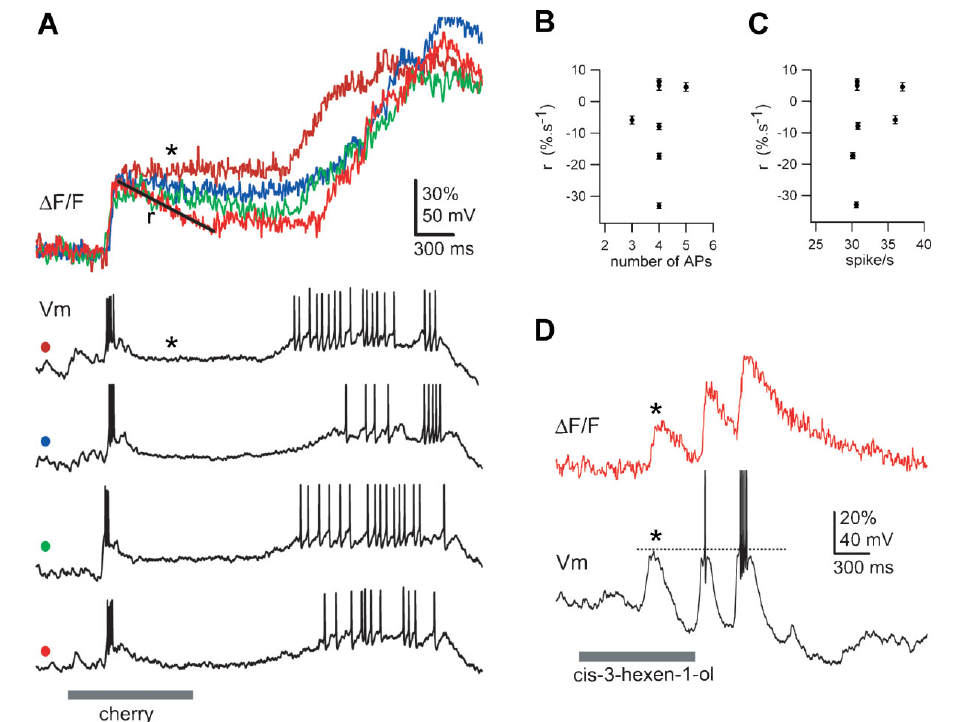
Figure 4. Calcium signals are not always correlated with spiking . ( A ) Seven glomeruli were successively imaged in this PN, using constant odor delivery conditions. Single trials of V m and F responses evoked by 1-second pulse of cherry odor are shown for four glomerular tufts (four colors). PN was held very slightly hyperpolarized. Note consistency of early F and V responses across glomeruli, to be contrasted with lack of correlation between F (linearly quantified as a rate r ± SD) in silent phase of the response and spiking response in preceding moments (in number of APs, B ; or rate, C ). ( D ) A different PN, held slightly hyperpolarized, in which F is revealed to vary substantially even with subthreshold event (*).